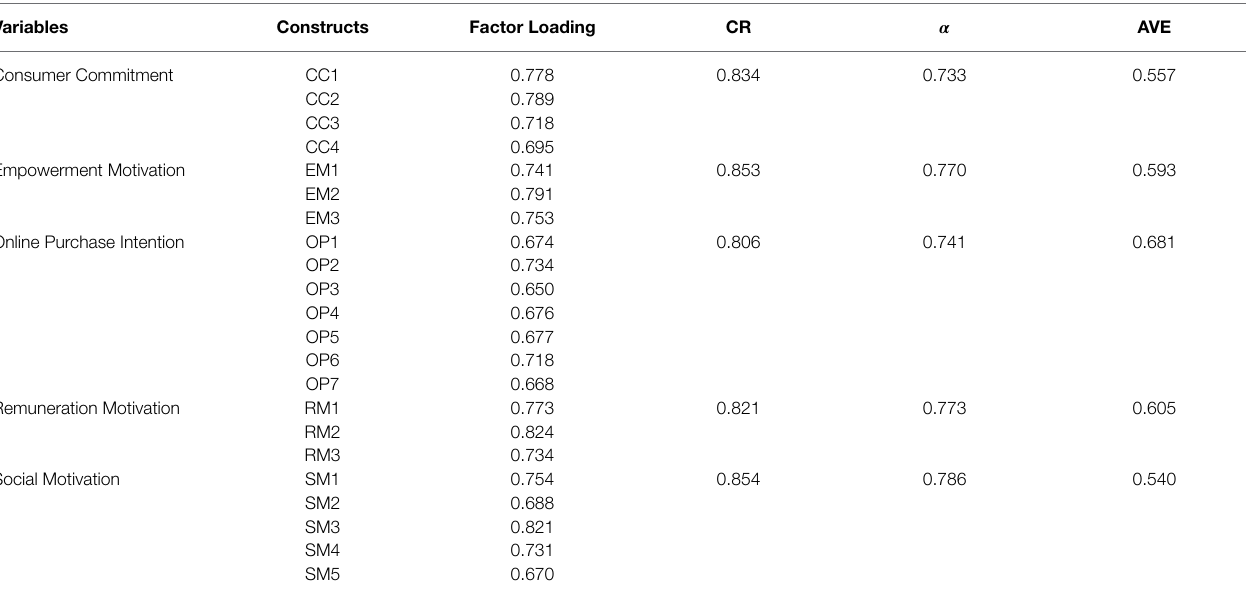
TABLE 1 | Inner model